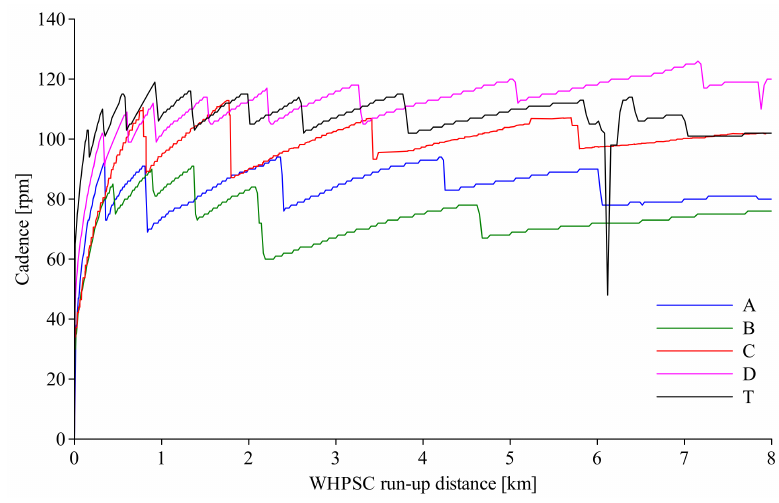
Figure 9. Cadence comparison for different vehicles during WHPSC run-up. Table 3. Cadence (rpm) statistical analysis for the compared vehicles